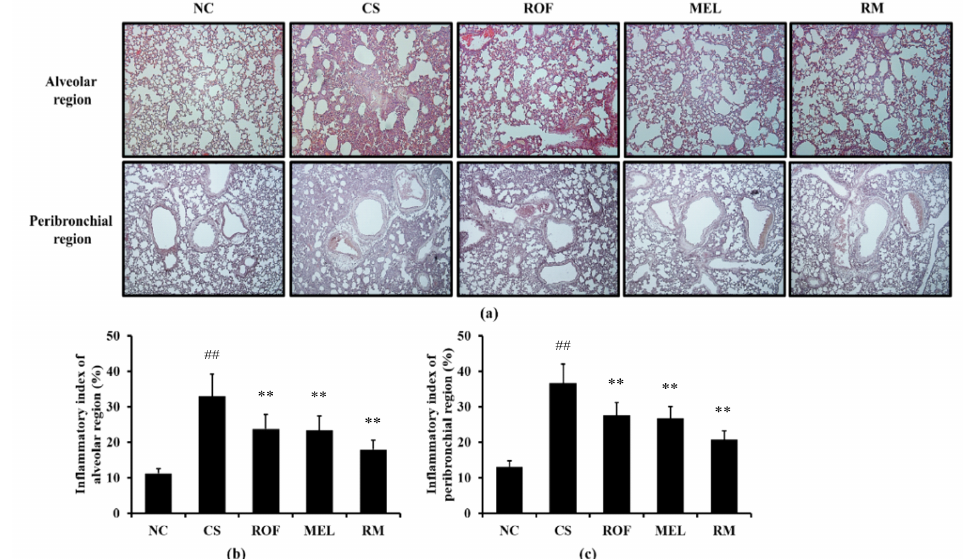
Figure 2. Melatonin reduced inflammatory cell infiltration in lung tissue of CS-exposed mice. The inflammatory cells infiltration was determined by H&E staining (n = 5). ( a ) lung histology stained with H&E, ( b ) inflammatory index of alveolar region, ( c ) inflammatory index of peribronchial region. NC: non-treated and non-exposure group; CS: PBS-treated and CS+LPS exposure group; ROF: roflumilast-treated and CS+LPS exposure group, MEL: melatonin-treated and CS+LPS exposure group, RM: roflumilast and melatonin co-treated and CS+LPS exposure group. The data are expressed as mean ± SD (n = 5). ## Significantly different from the NC group, P < 0.01; ** significantly different from the CS group, P < 0.01.